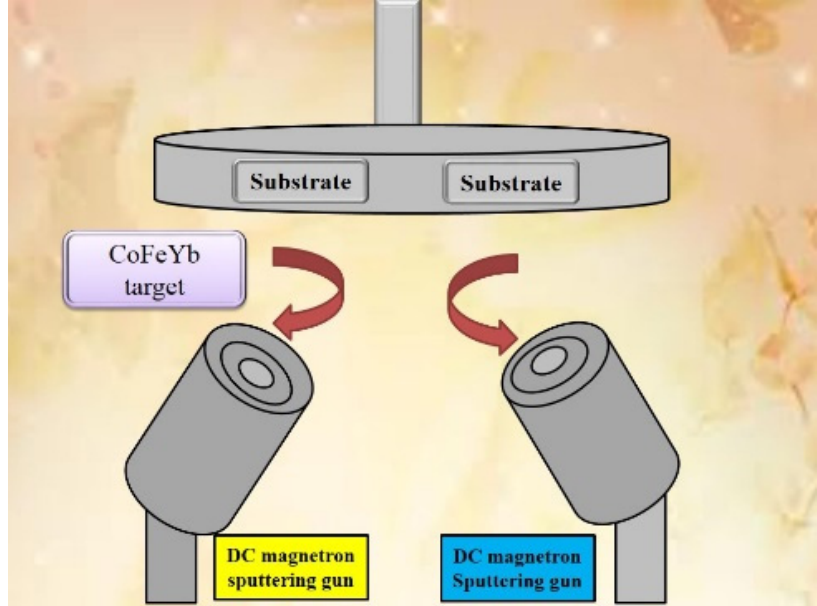
Figure 1. Schematic diagram of sputtering system.